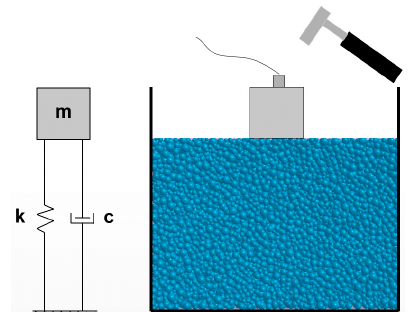
Figure 1. Analytical model and schematic test rig.